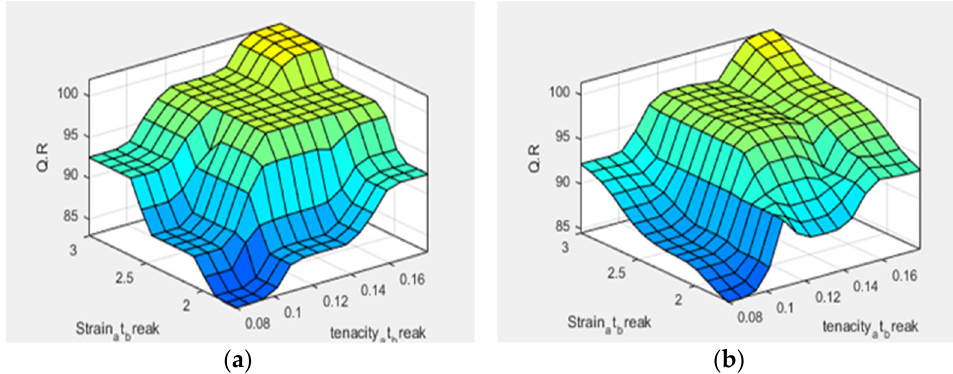
Figure 10. Surface view of tenacity at break (X-axis) and strain at break (Y-axis) effect on jute yarn quality (Z-axis); ( a ) for triangular membership function and ( b ) gaussian membership function.